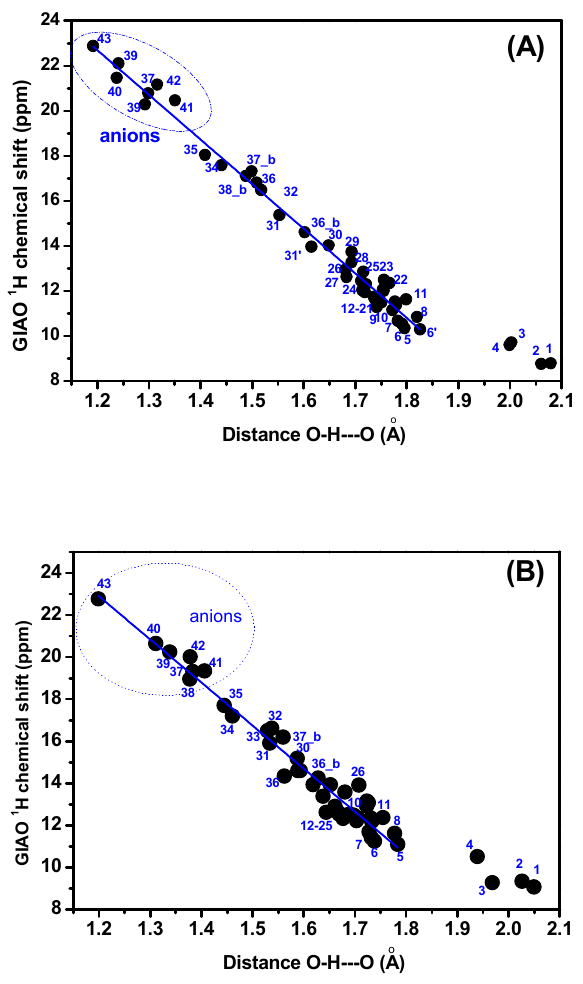
Figure 13. Calculated (at the GIAO/B3LYP/6-311+ G(2d,p) level of theory with CPCM in CHCl 3 ) OH proton chemical shifts vs. calculated (O)H ··· O distances, Å, of the compounds of Figure 9 with minimization of the structures at the M06-2X/6-31+G(d) ( A ) and B3LYP/6-31+ G(d) ( B ) level of theory. The notation b refers to the bent complex (see text and Table 1). Reprinted, with permission, from [47]. Copyright 2015, The Royal Society of Chemistry.